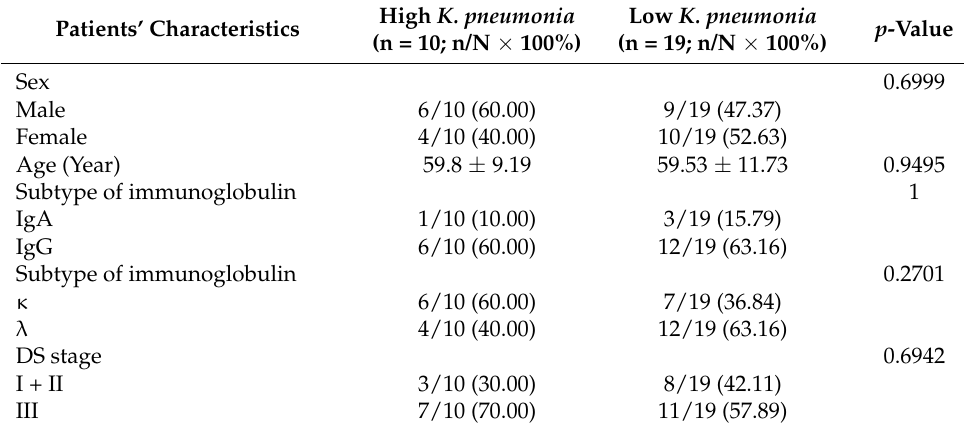
Table 1. The correlation between intestinal K. pneumonia abundance and clinical characteristics of newly diagnosed MM